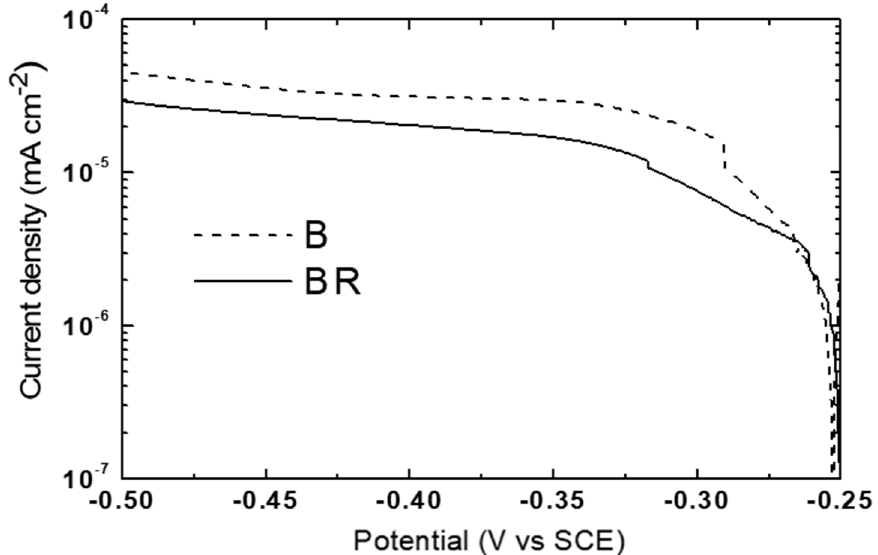
Figure 9. Polarisation curves obtained in 3.5 wt.% NaCl solution for B (as cast) and BR (annealed) samples from the OCP values to -0.5V at 1 mV s − 1 .